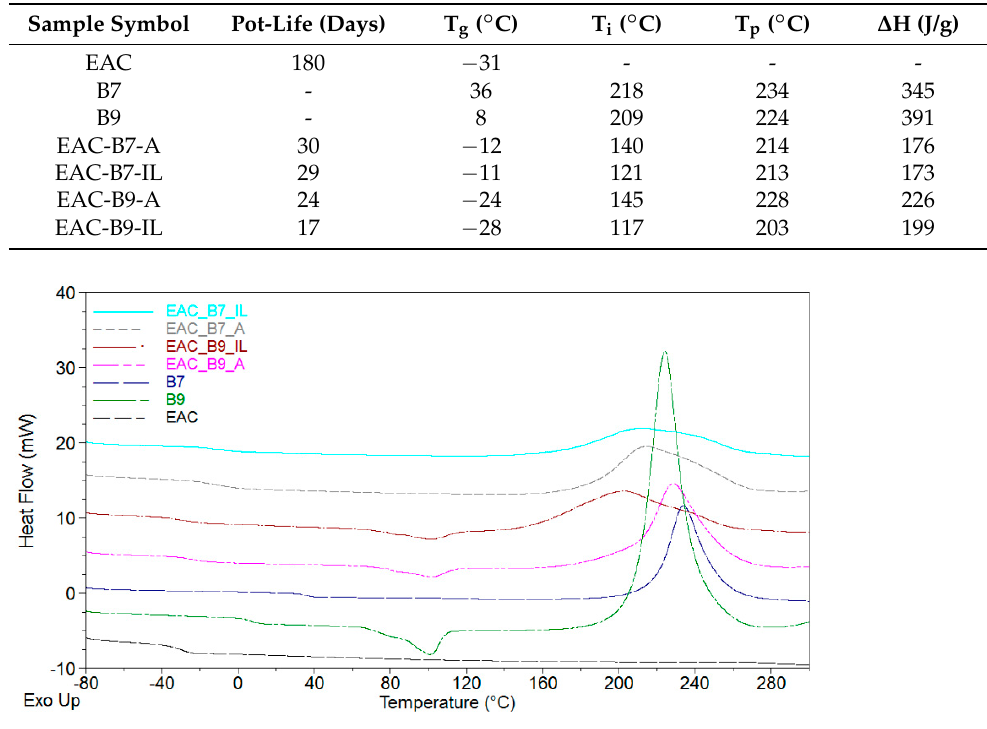
Figure 2. DSC thermographs for an epoxyacrylate copolymer (EAC), benzoxazine resins (B7 and B9), and the composition of the epoxyarylate copolymer with benzoxazine resins and the latent curing agent (2.5 wt. parts).